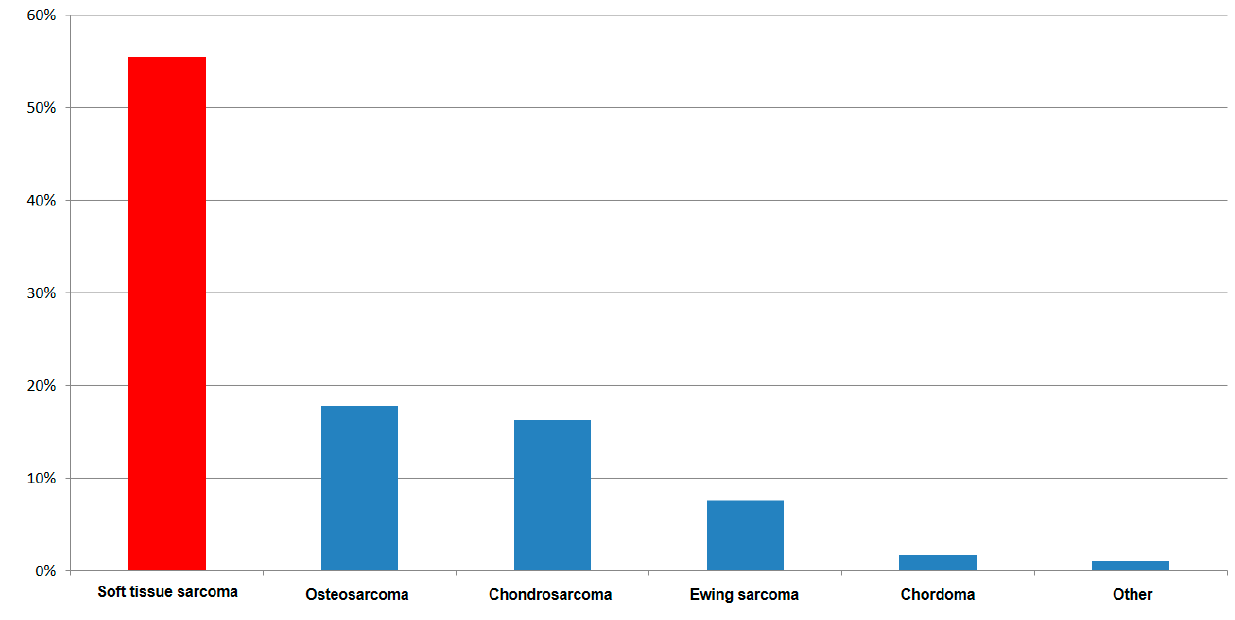
Figure 1. Tumor entities in 417 patients.